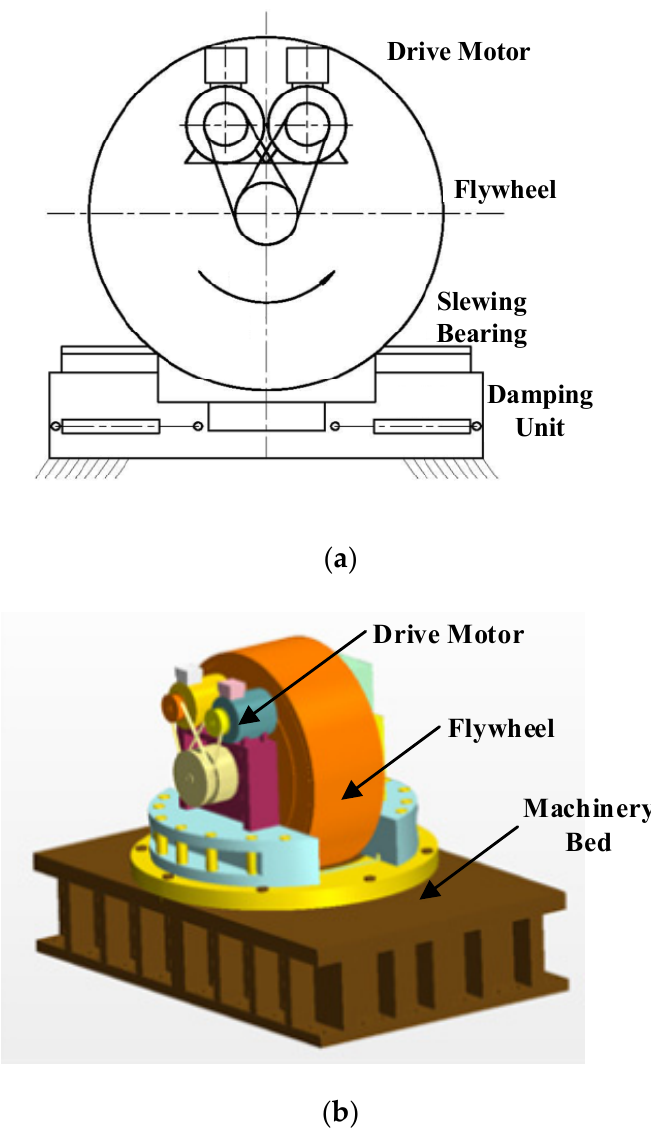
Figure 1. Physical model of the marine gyrostabilizer. ( a ) Project drawing; ( b ) Assembly drawing. The main parameters of the gyrostabilizer flywheel are shown in Table 1. Table 1. Major parameters of the marine gyrostabilizer flywheel.